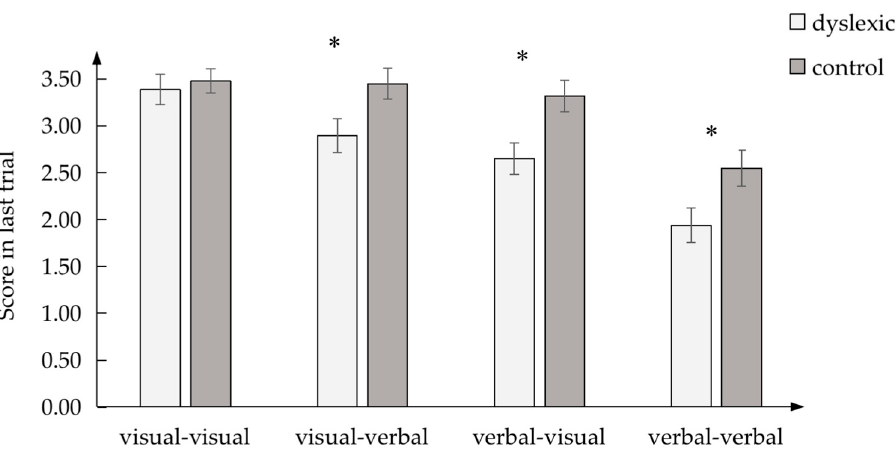
Figure 2. Final learning effect in four PAL conditions between dyslexic and control groups; * p < 0.05.